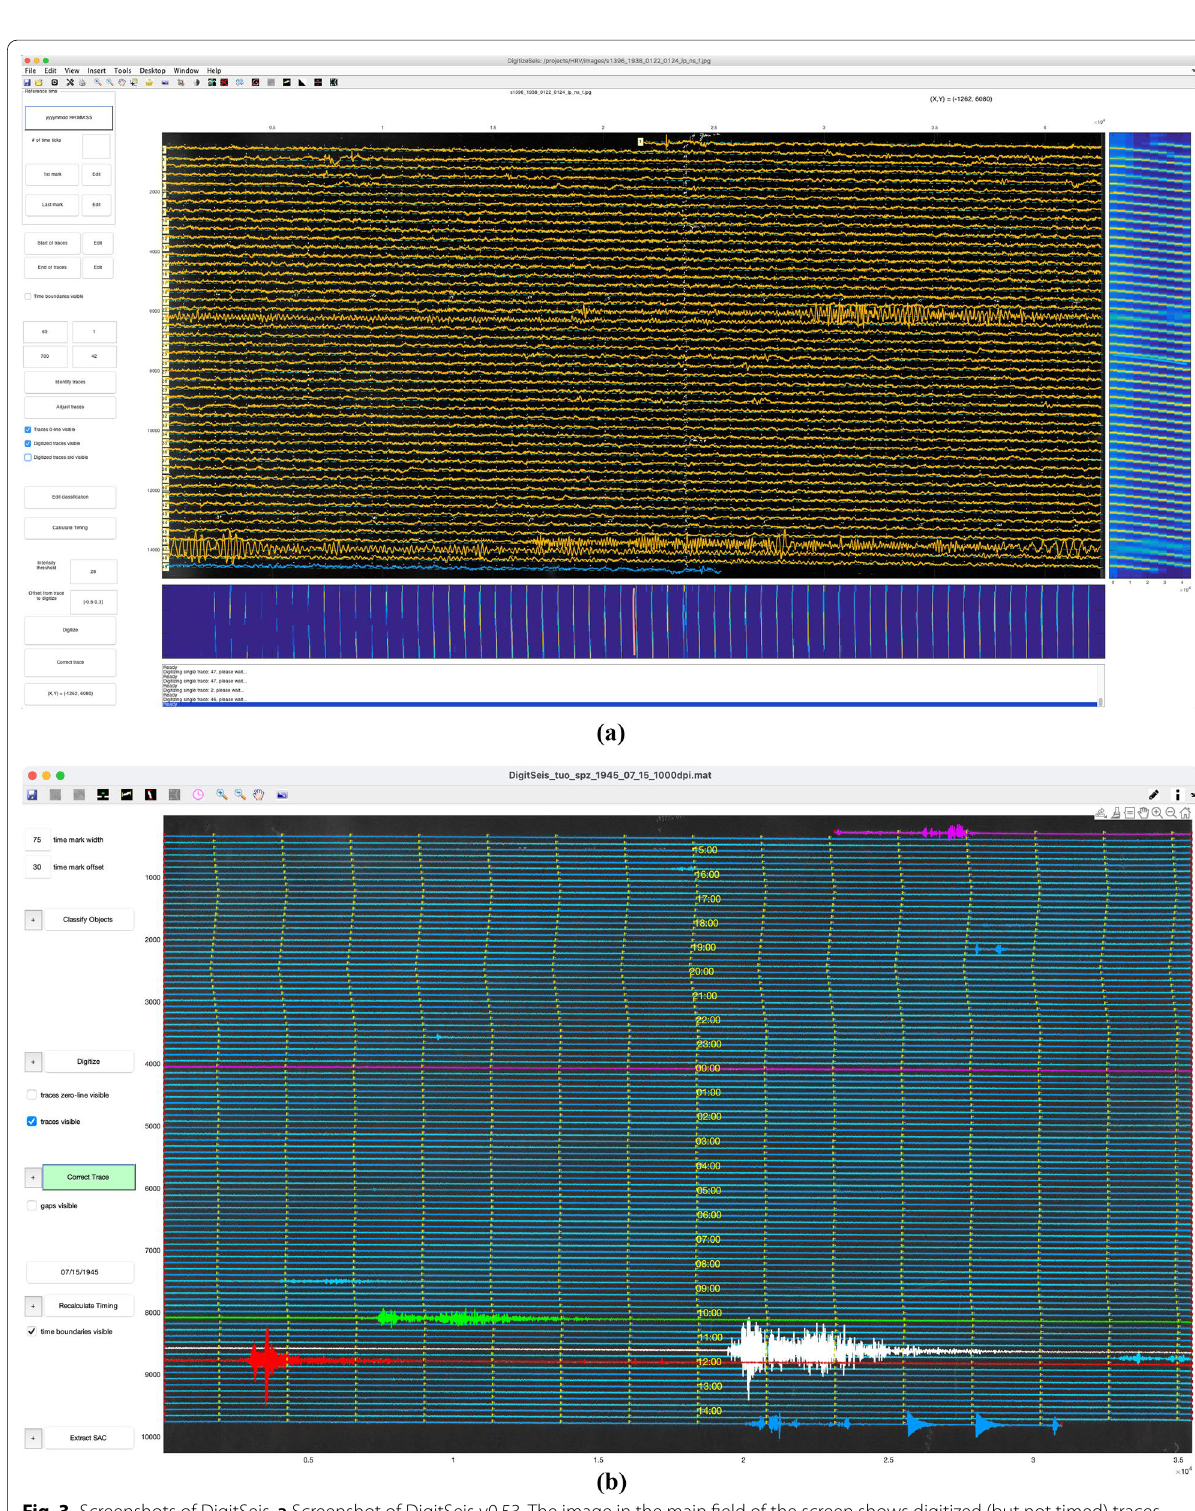
Fig. 3 Screenshots of DigitSeis. a Screenshot of DigitSeis v0.53. The image in the main field of the screen shows digitized (but not timed) traces of a long-period north–south recording from January 22–24, 1938. The arrivals in the middle of the window are associated with a magnitude 6.6 earthquake in Maui, Hawai‘i, and the later arrivals are from a magnitude 7.0 earthquake in the Scotia Sea (ISC 2022). b Screenshot from DigitSeis v1.5. The image shows the original short-period vertical recording from July 15–16, 1945, that has been digitized (colored lines) and timed (yellow vertical bars with labels for every hour). This recording is from Tucson, AZ, and the large arrivals in white are those from the Trinity nuclear